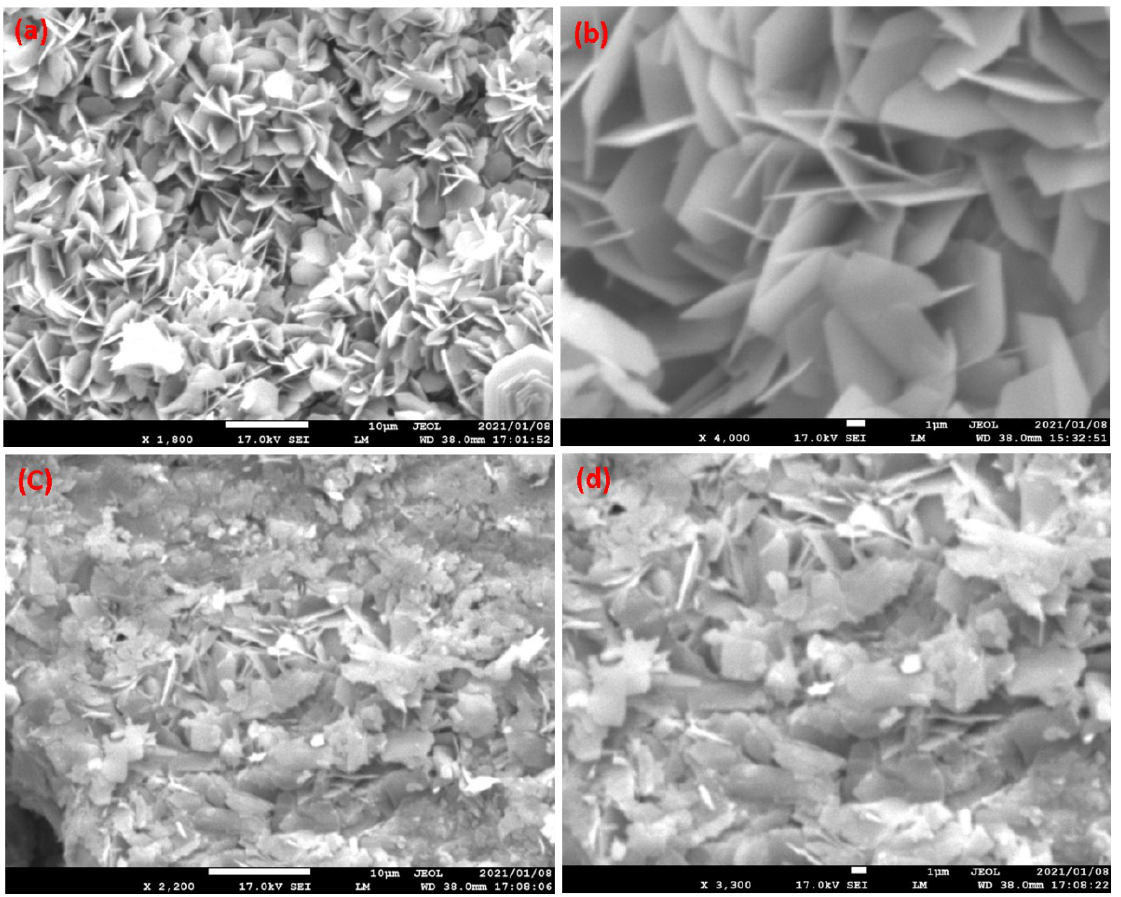
Figure 4. SEM images of ( a , b ) V 2 O 5 and ( c , d ) V 2 O 5 /RGO composite, at different magnifications.